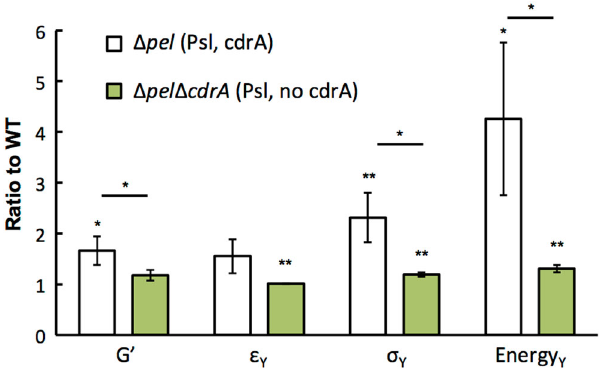
Fig. 6 Production of the protein CdrA is needed for the stiffening (increased G ′ ), strengthening (increased σ Y ), and toughening (increased yield energy Energy Y ) effects of Psl. For Δ pel strains that produce Psl but not Pel, bio fi lm mechanics are enhanced compared to the WT only if CdrA is also produced. ( n =